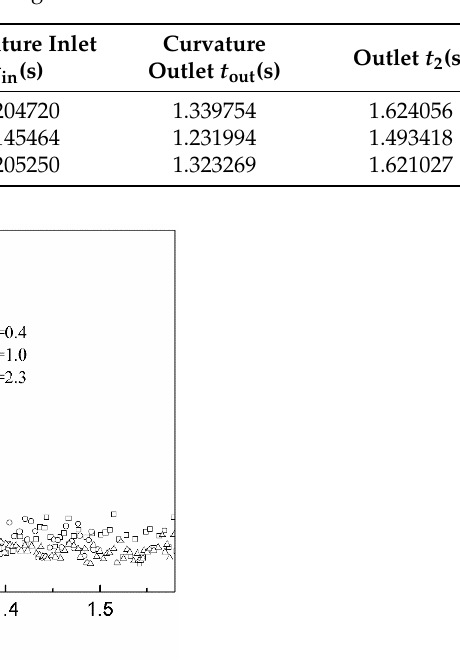
Table 7. Effects of Ar on particle motion time through the whole duct.